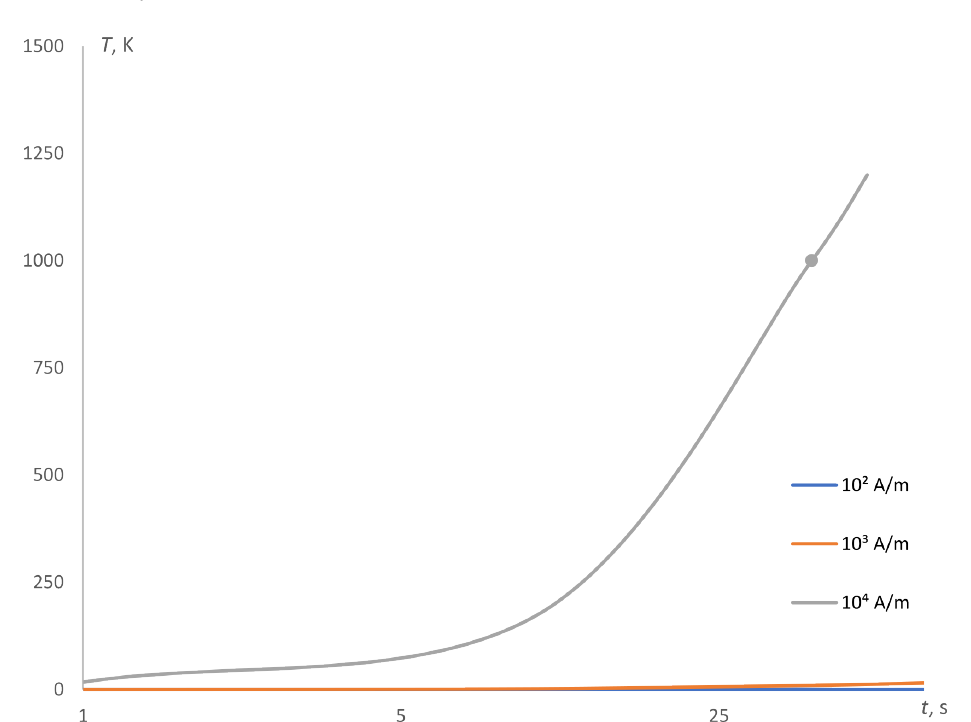
Figure 4. Temperature dependence on time duration of inductive heating NEMF t i with different values of H 0 .